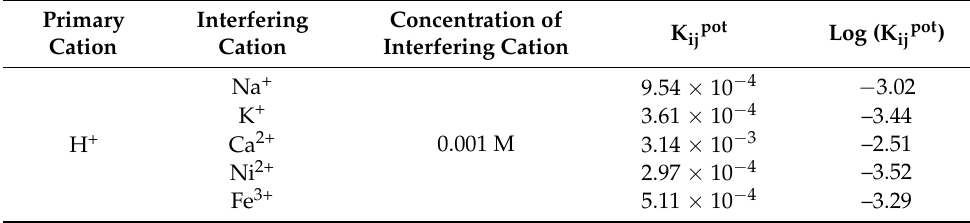
Table 4. The selectivity coefficients of the fabricated electrode for Na + , K + , Ca 2+ , Ni 2+ , and Fe 3+ .